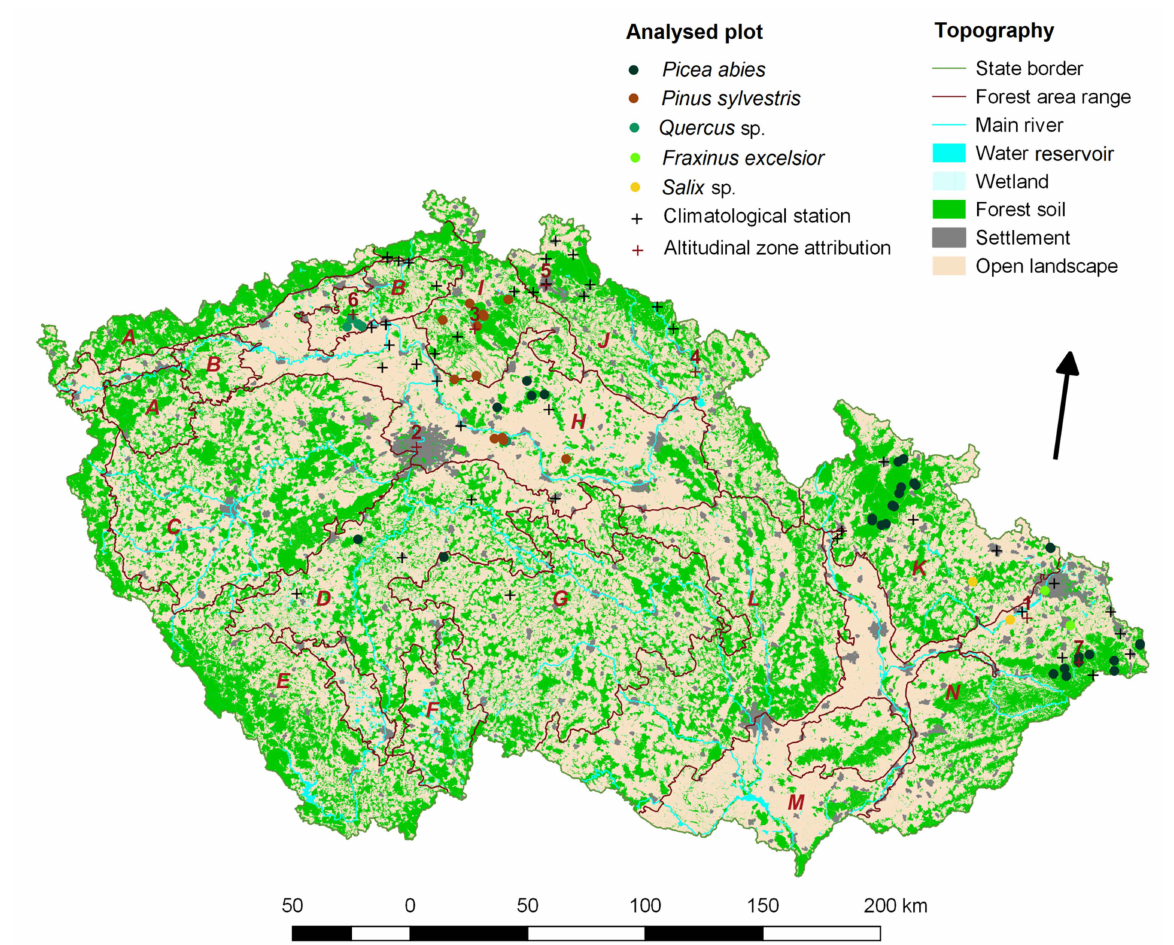
Figure 1. Distribution of selected forest stand types in relation to climatological stations includ- ing attribution of time series at investigated altitudinal zones. Forest area ranges: A—Ore Mts.; B—Volcanic Mts.; C—Beroun; D—Central Bohemia; E—Bohemian Forest; F—South-Bohemian basins; G—Bohemian-Moravian Highland; H—Elbe basin; I—North-Bohemian sandstone; J—Western Sudetes; K—Eastern Sudetes; L—Moravian Foothills; M—Moravian Floodplains; N—Outer Western